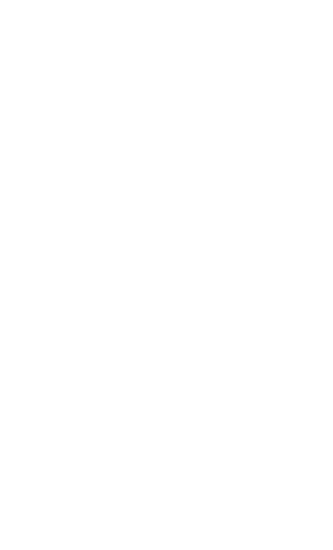
Multivariable GEE analysis revealed that the factors showing the strongest association with general health scores, indicated by the largest coefficient values (GH Model 2), were the avail- ability of social support, income management and level of education. After adjustment for other variables within GH Model 2, women who had social support that was available ‘ none/lit- tle/some of the time ’ had a mean general health score that was 2.16 points lower than women with social support available ‘ most/all of the time ’ (p (cid:1) 0.01; 95% CI -3.22 – -1.10). Women who found it ‘ not too bad/easy ’ to manage on their income had general health scores that were on average 3.03 points higher than women who found it ‘ impossible/difficult ’ to manage on their income (p (cid:1) 0.01; 95% CI 2.00 – 4.06). Women with a university level of education had a mean general health score that was 4.14 points higher than women who had not completed sec- ondary school (p (cid:1) 0.01; 95% CI 1.85 – 6.44). Unadjusted and adjusted models for SF-36 Mental Health subscale scores are given in Table 3. Multivariable GEE modelling indicated a slight effect of rurality on the mean mental health scores of women with a history of IPV. Women who lived in rural areas had a signifi- cantly higher mean mental health score than women who lived in major cities (p (cid:1) 0.05; 95%